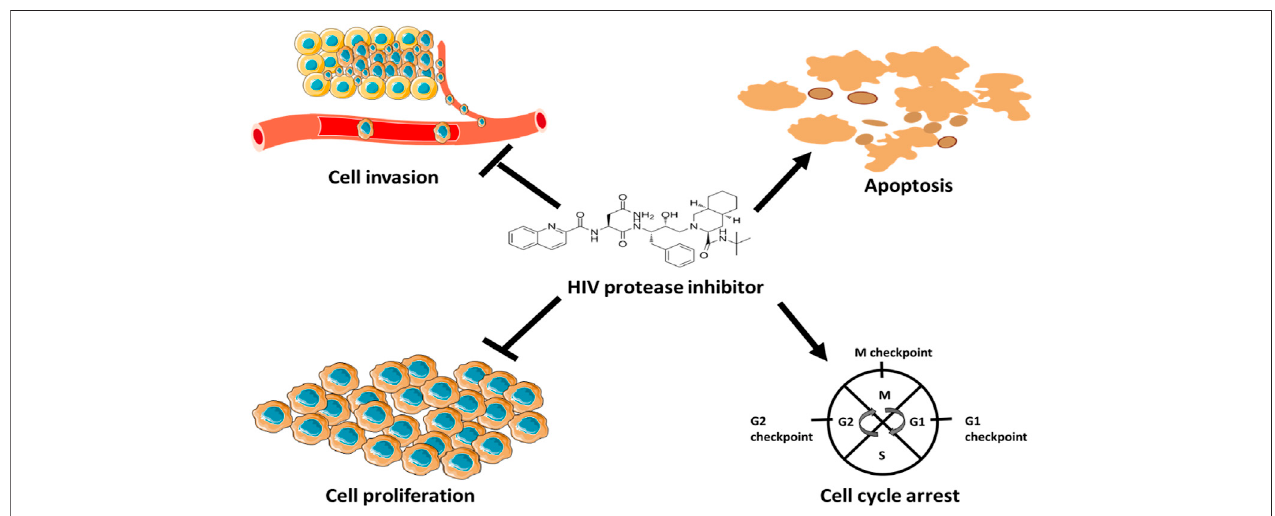
FIGURE 5 | Anticancer mechanisms of HIV protease inhibitors. HIV protease inhibitors induce anticancer mechanisms by blocking MMPs activity and stimulating the production ROS. MMPs facilitate angiogenesis and ROS regulate cell cycle and trigger cytochrome c release to induce apoptosis.